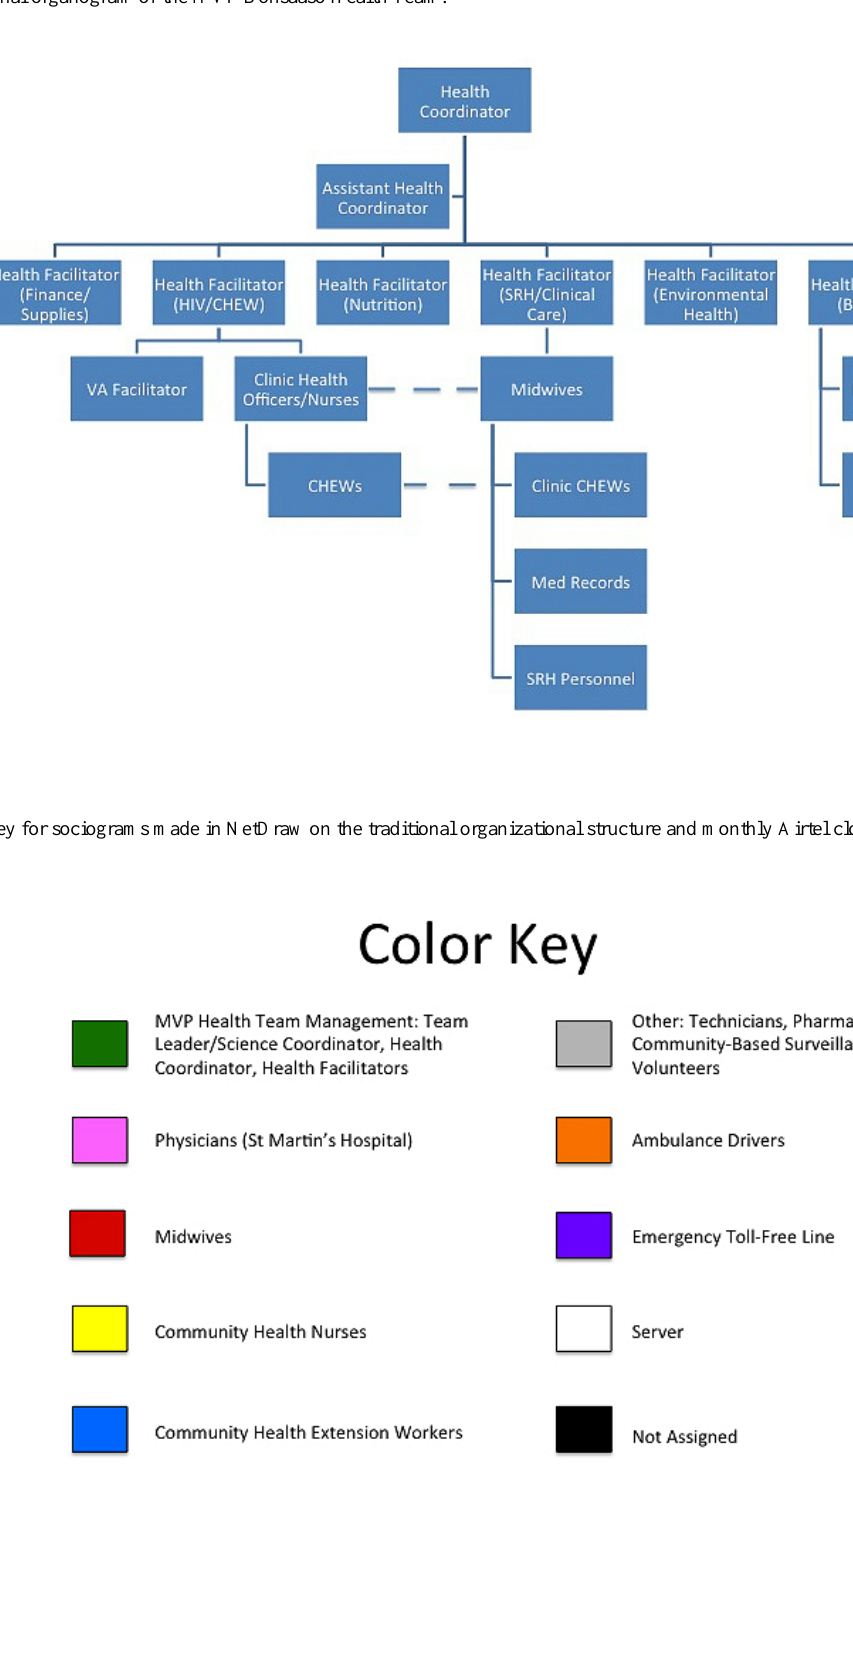
Figure 1. Traditional organogram of the MVP Bonsaaso Health Team.